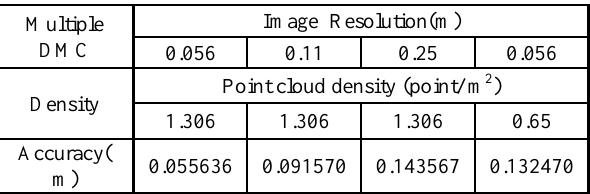
Table 3 Rgistration result of multi-image based on linear feature instead of point feature